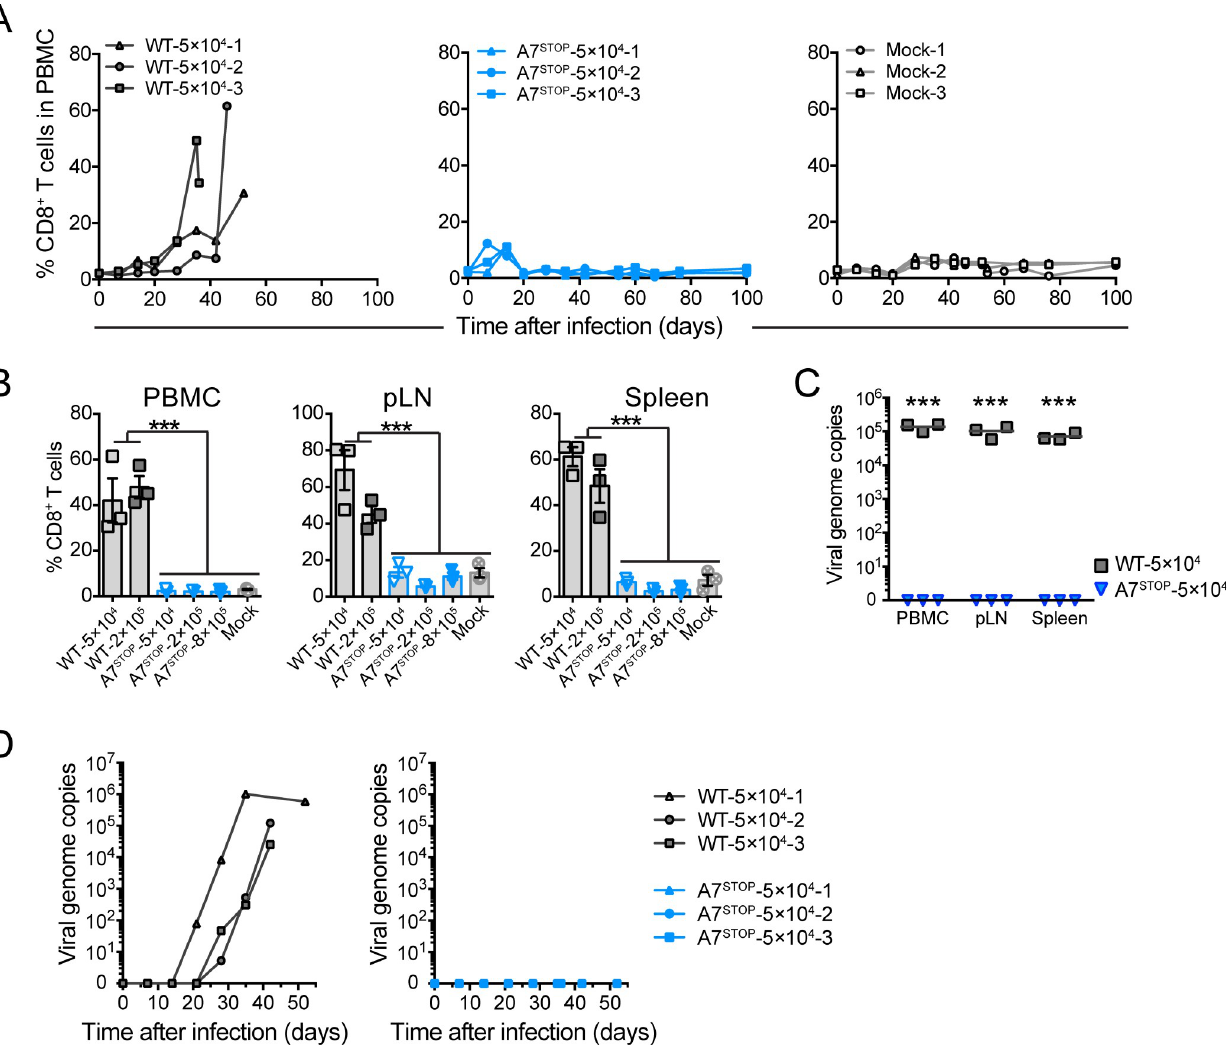
Fig 9. Lack of A7 results in the absence of expansion of CD8 + T lymphocytes and viral persistence in peripheral blood after intranasal infection. Rabbits were infected by intranasal inoculation of different doses (5 × 10 4 , 2 × 10 5 or 8 × 10 5 PFU per rabbit) of C500 BAC − WT and BAC − A7 STOP-207 . (A) Percentages of CD8 + T cells in PBMCs analyzed by flow cytometry at regular intervals throughout the experiment. Data are plotted for individual rabbits. (B) Percentages of CD8 + T cells in PBMCs, popliteal lymph nodes (pLN) and spleen at the time of euthanasia, as analyzed by flow cytometry. Data show mean ± SEM with data plotted for each individual rabbit. (C) qPCR of viral genome copies in PBMCs over time. (D) qPCR of viral genome copies in PBMCs, pLN and spleen at the time of euthanasia. Real-time PCR quantification was normalized on 10 5 copies of the cellular β -globin gene sequence. Data are plotted as individual measurements. Bars show mean values. One-way ANOVA with Bonferroni’s post-hoc test was used to identify significant differences ( ��� P < 0.001).